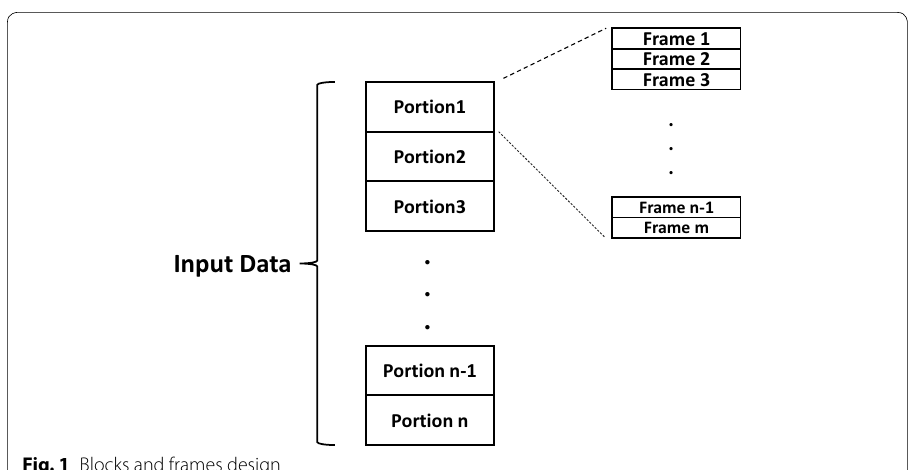
Fig. 1 Blocks and frames